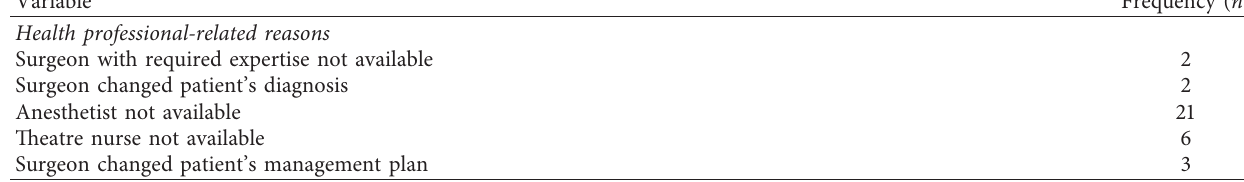
Table 2: Reasons for cancellation of elective procedures in surgical wards at Mulago Hospital, Uganda. Variable